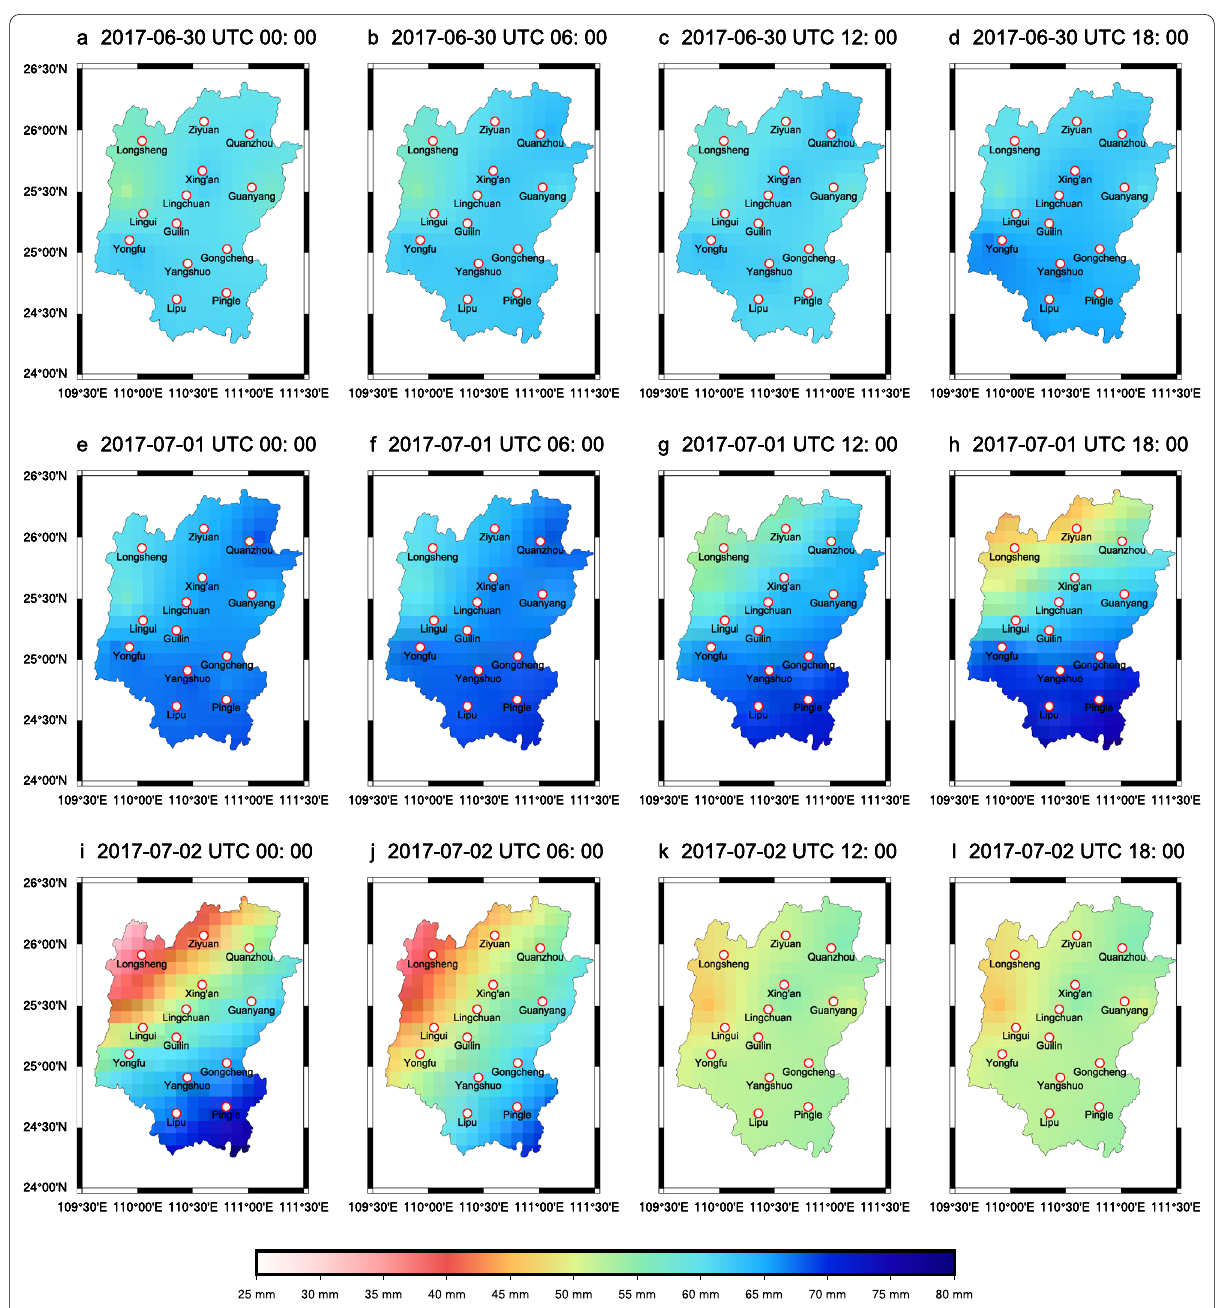
Fig. 10 Spatial evolution of GNSS-PWV for Guilin every 6 h from June 30 to July 2,